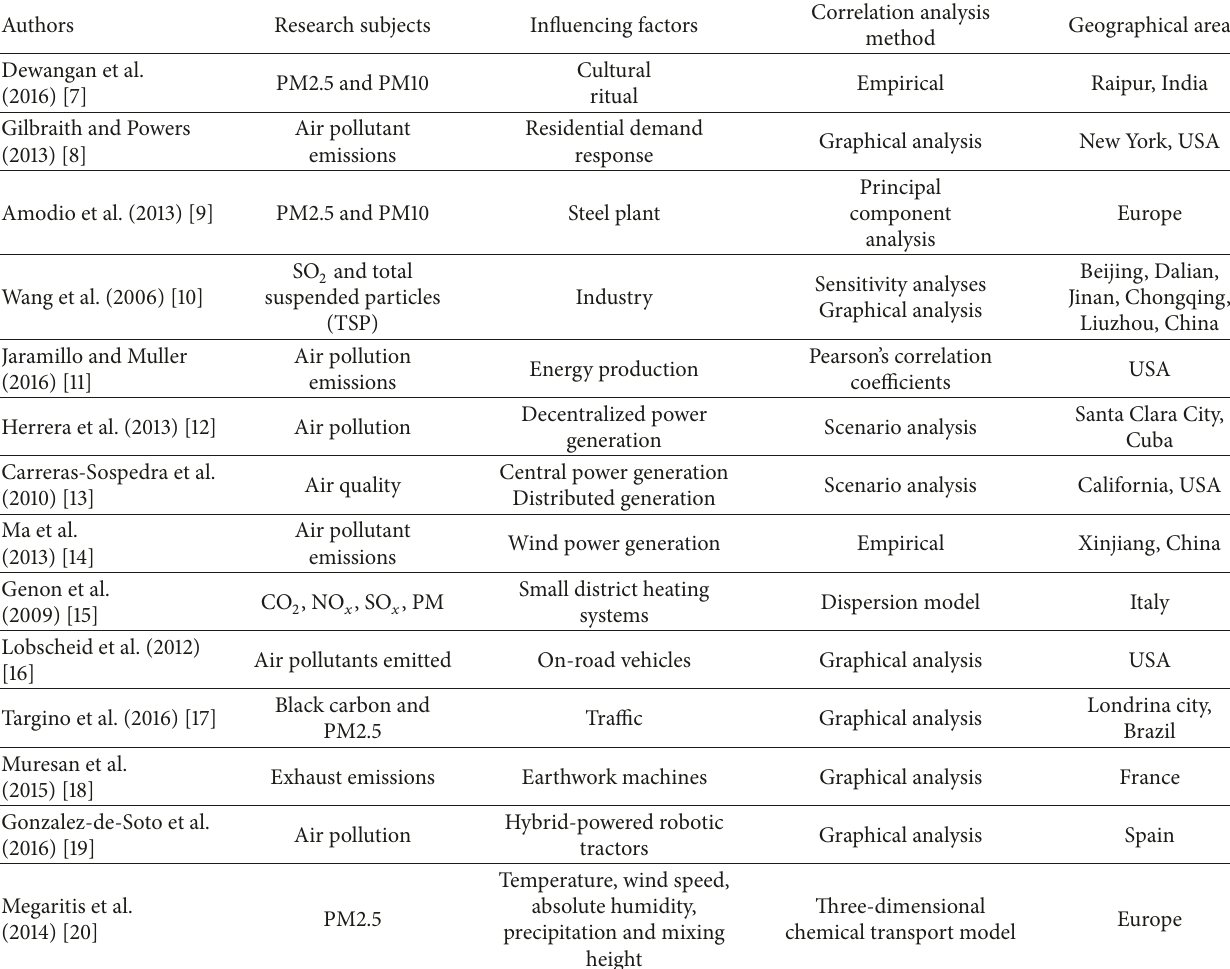
Table 1: Information on influencing factors and analyzing methods in related papers.